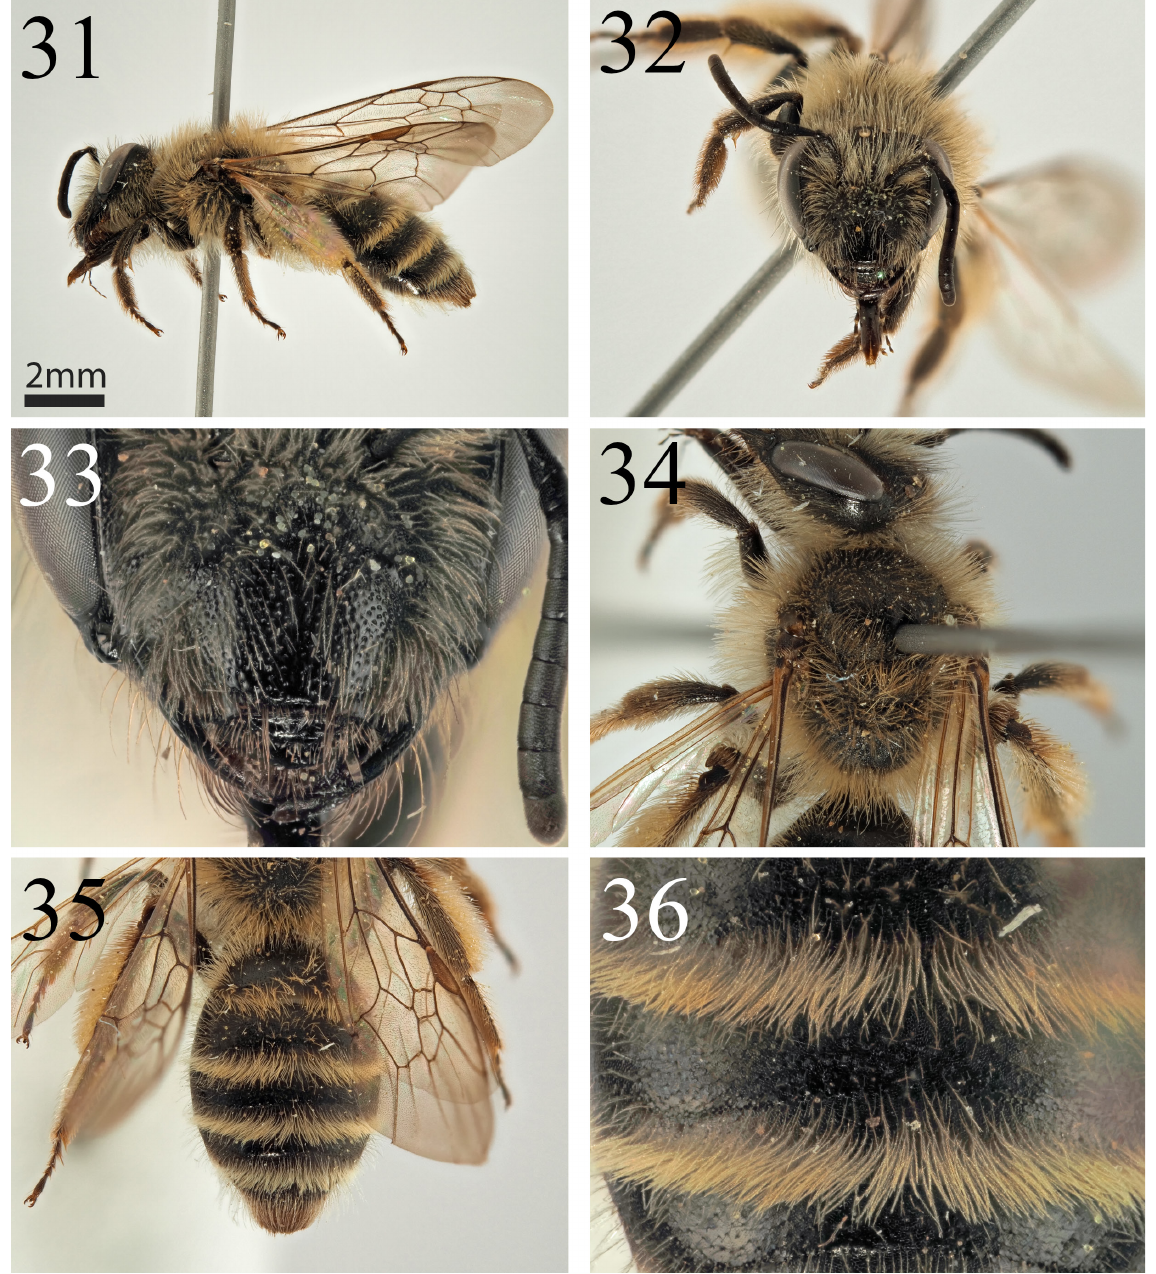
Figs 31–36. Andrena sani sp. nov., ♀ (OÖLM). 31 . Profile. 32 . Face. 33 . Face, detail. 34 . Dorsum. 35 . Terga. 36 . Terga,